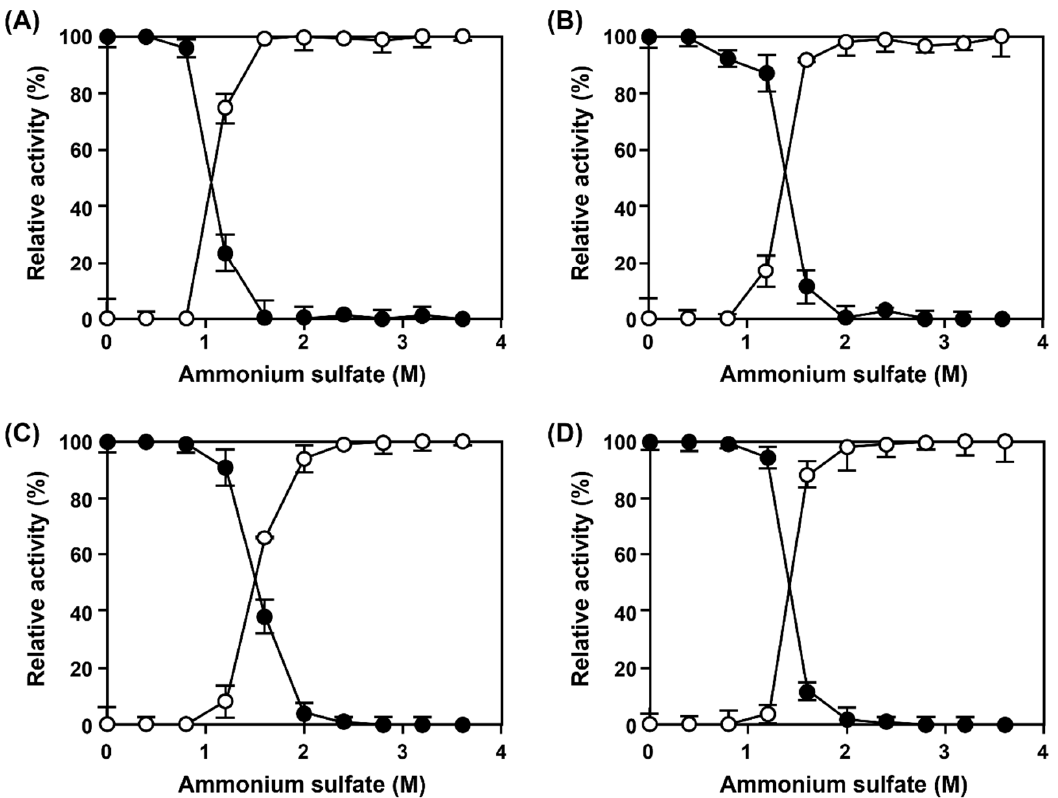
Figure 1. Effects of ammonium sulfate (AS) on the aggregation of the mixture of amine oxidases copper-containing monoamine oxidase (AMAO2) and a flavin-containing putrescine oxidases (APUO) and the fusion enzyme (MAPO). Results of the monoamine oxidase activity using tyramine as the substrate ( A ) and putrescine oxidase activity using putrescine as the substrate ( B ) of the supernatant ( ● ) and the pellet ( ○ ) for the AMAO2 and APUO mixture; results of monoamine oxidase activity ( C ) and putrescine oxidase activity ( D ) of the supernatant ( ● ) and the pellet ( ○ ) for MAPO. The aggregation was conducted at 25 ° C for 1h, followed by centrifugation to separate the precipitate and the supernatant. The activities were measured using the supernatant and the aggregates re- dissolved in 100 mM phosphate buffer (pH 7.0) after proper dilution. The activities of amine oxidases were measured according to the peroxidase-coupled assay [16] using tyramine as the substrate at the optimum condition of each enzyme.